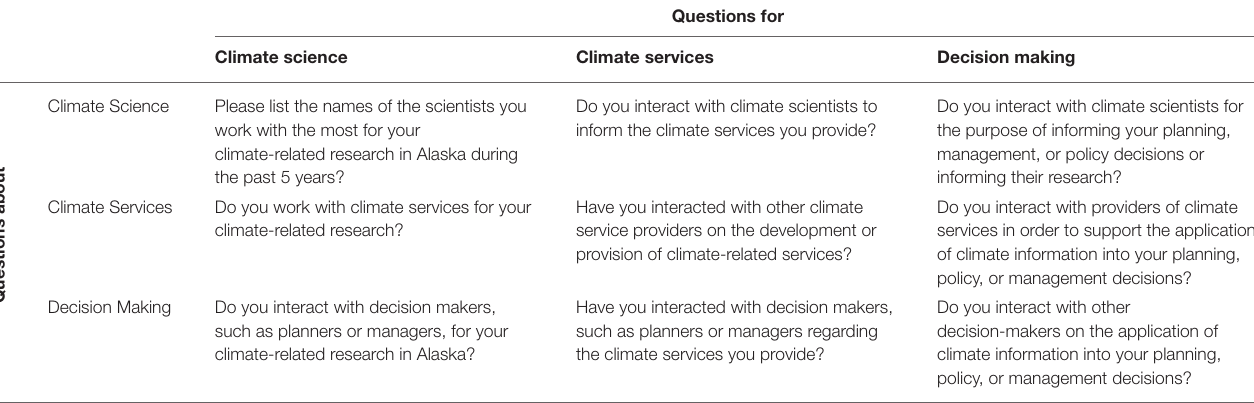
TABLE 2 | Questions to elicit interactions among scientists, service providers, and decision